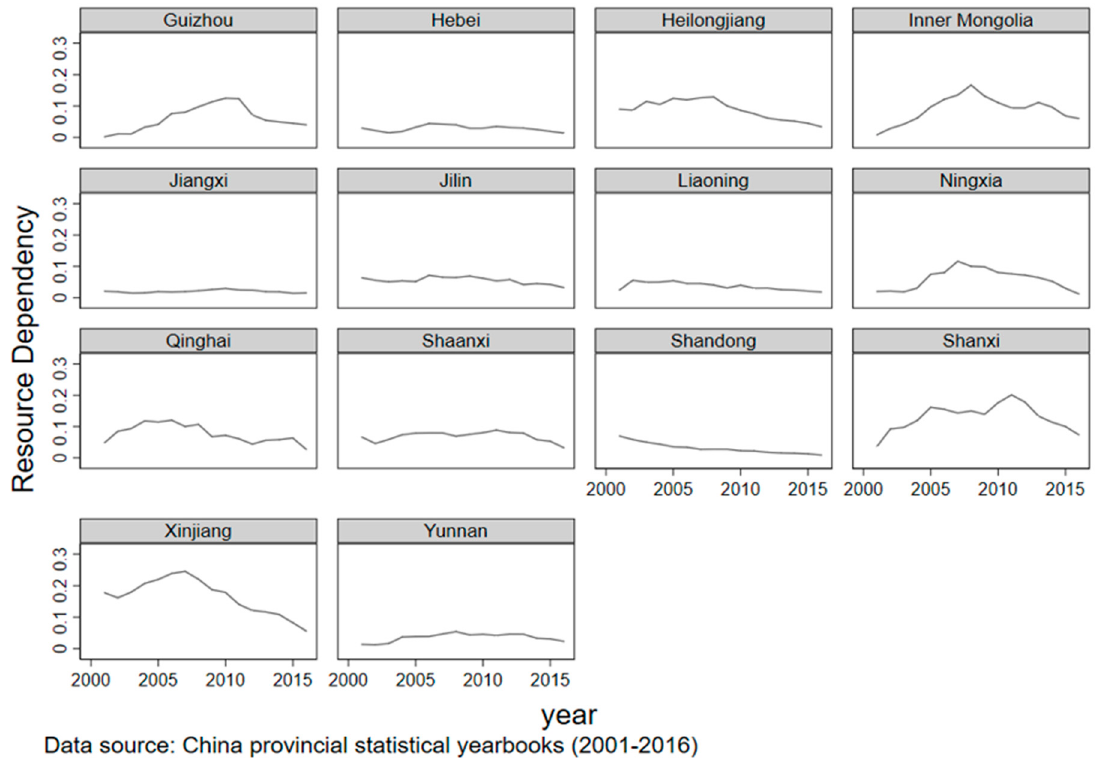
Figure 3. Energy resource dependence of each province, 2001–2016.